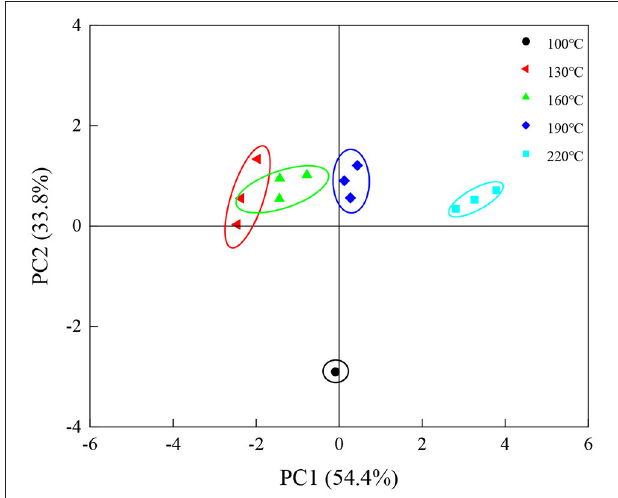
FIGURE 6 | Electronic-tongue principal component analysis plot of eel burgers baked at various temperatures. FIGURE 7 | In vitro digestibility of eel burgers baked at various temperatures.